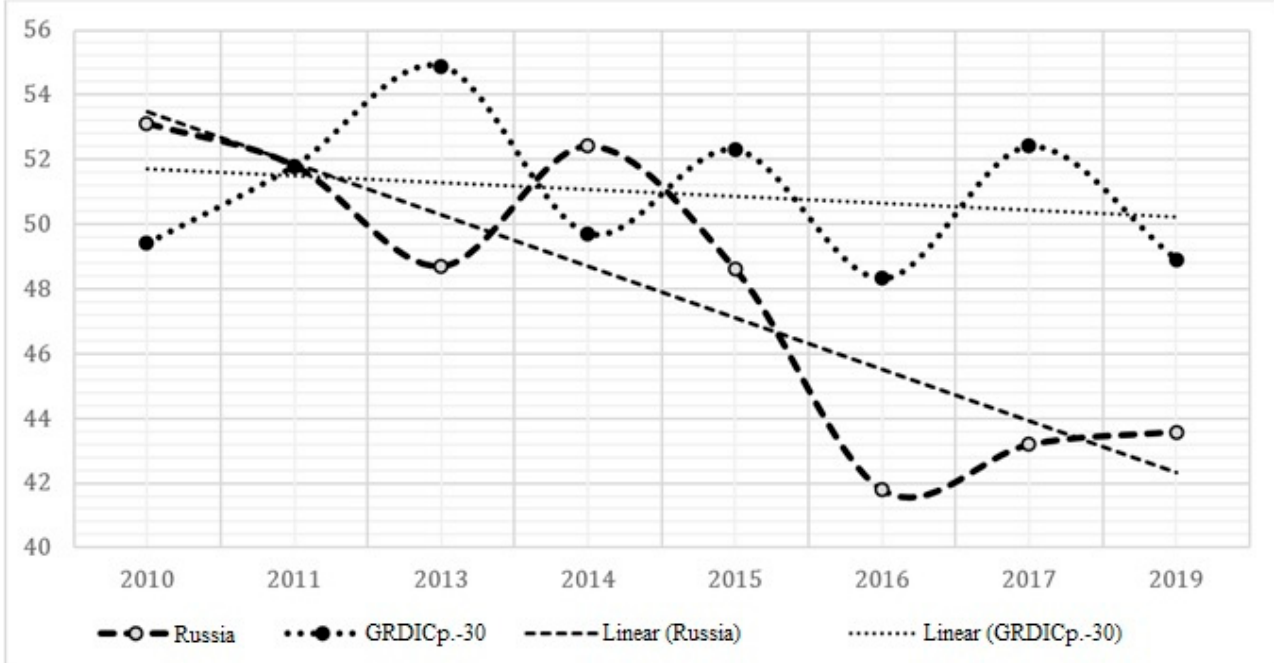
Figure 5. GRDI for Russia vs. average GRDI for 30 countries included in the assessment of attractiveness for retail chain development (developed by the authors based on data from A. T. Kearney Global Retail Development Index: https://www.kearney.com/global-retail-development-index).